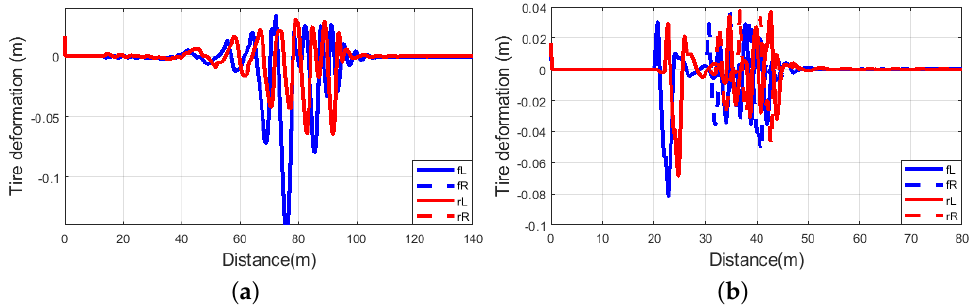
Figure 14. ( a ) Tire deformation of sine sweep, ρ = 1. ( b ) Tire deformation of sine sweep, ρ = 0.